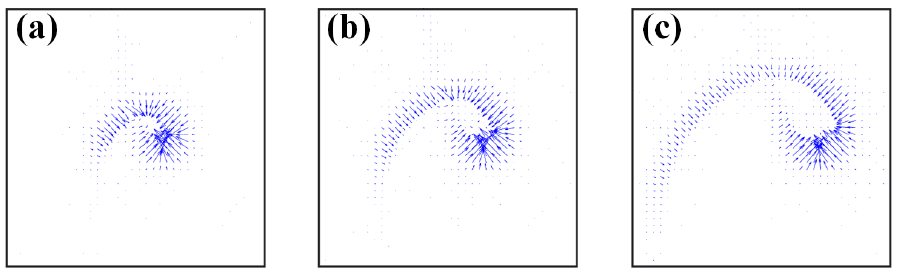
Figure 3. ( a – c ) The transverse energy flow of the spoon-like beams with l = − 5, n = 0.4, 0.5, and 0.6 at the focal plane, respectively.